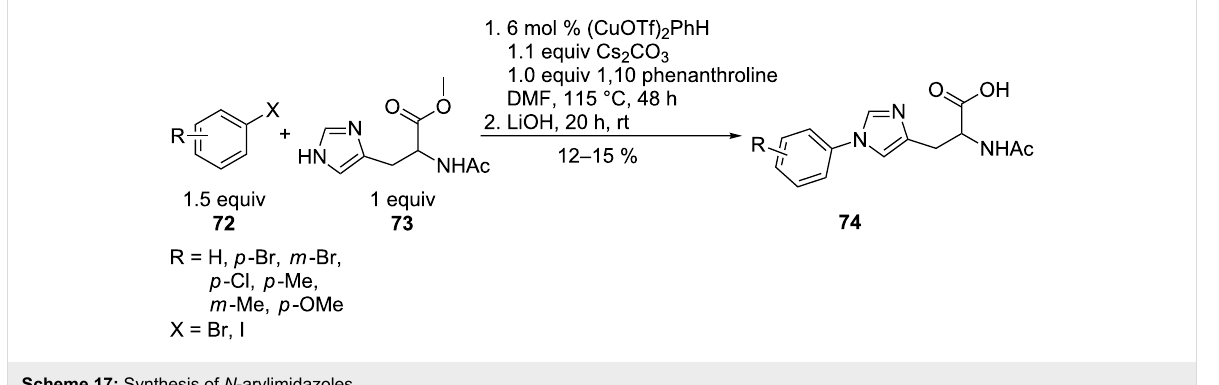
Scheme 17: Synthesis of N -arylimidazoles.